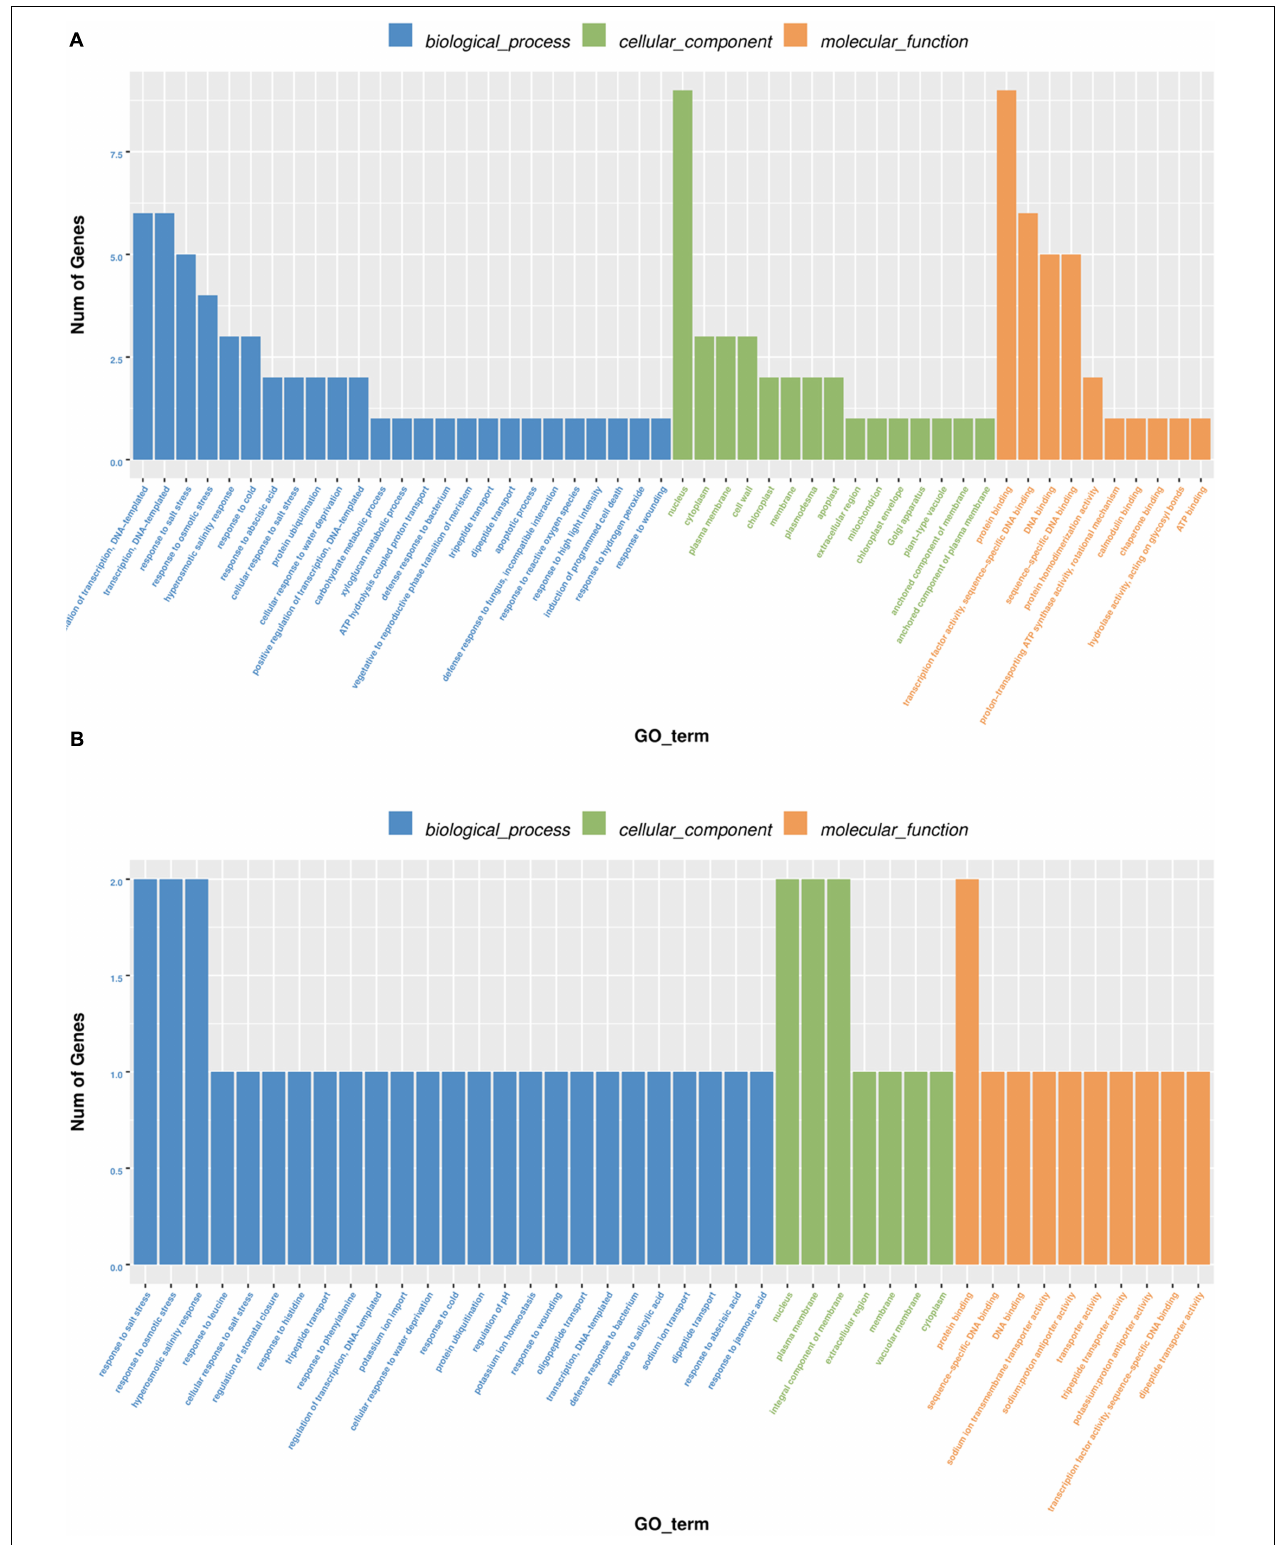
FIGURE 5 | Gene ontology enrichment of five lncRNAs as ceRNA regulated protein-coding genes in M-81E (A) and in Roma (B) . The results summarize the three main categories: biological processes, molecular functions, and cellular components. The y-axis represents the number of genes and the x-axis represents the GO functional